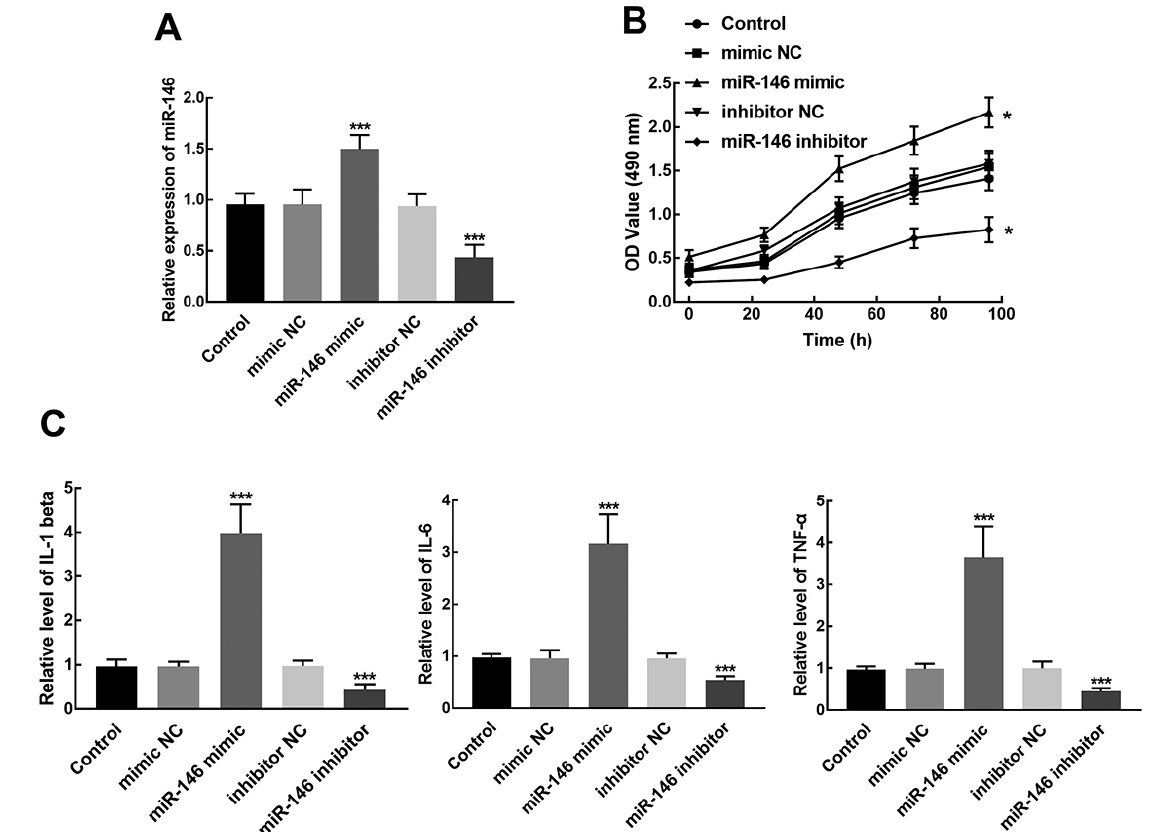
Figure 4 – Effect of miR-146 on fibroblasts proliferation and relative levels of pro-inflammatory cytokines in isolated primary human epidural fibroblasts. A. The transfection of miR-146 mimic significantly increased the expression of miR-146, while the transfection of miR-146 inhibited the expression of miR146. *** P < 0.001 relative to control (untransfected cells). B. The proliferation of fibroblasts was promoted by the overexpression of miR-146 and suppressed by the knockdown of miR-146. * P < 0.05 relative control. C. The relative levels of IL-1 beta, IL-6, and TNF-α increased by the overexpression of miR-146 and reduced by the silencing of miR-146. *** P < 0.001 relative to